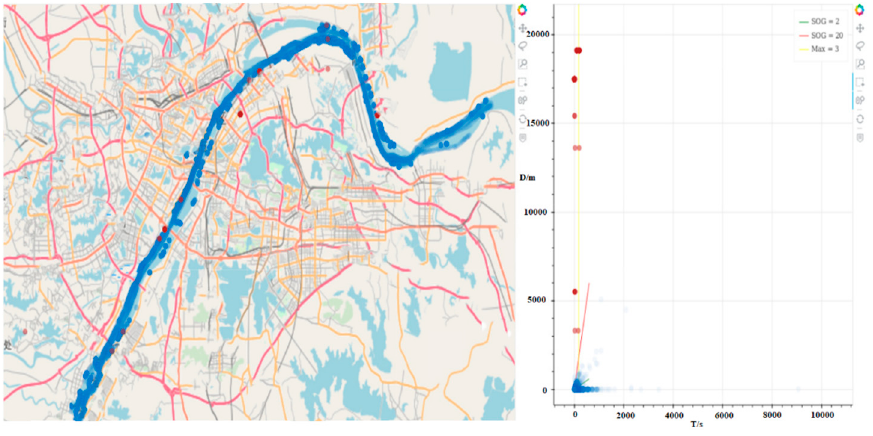
Figure 11. Selection of abnormal trajectory points.